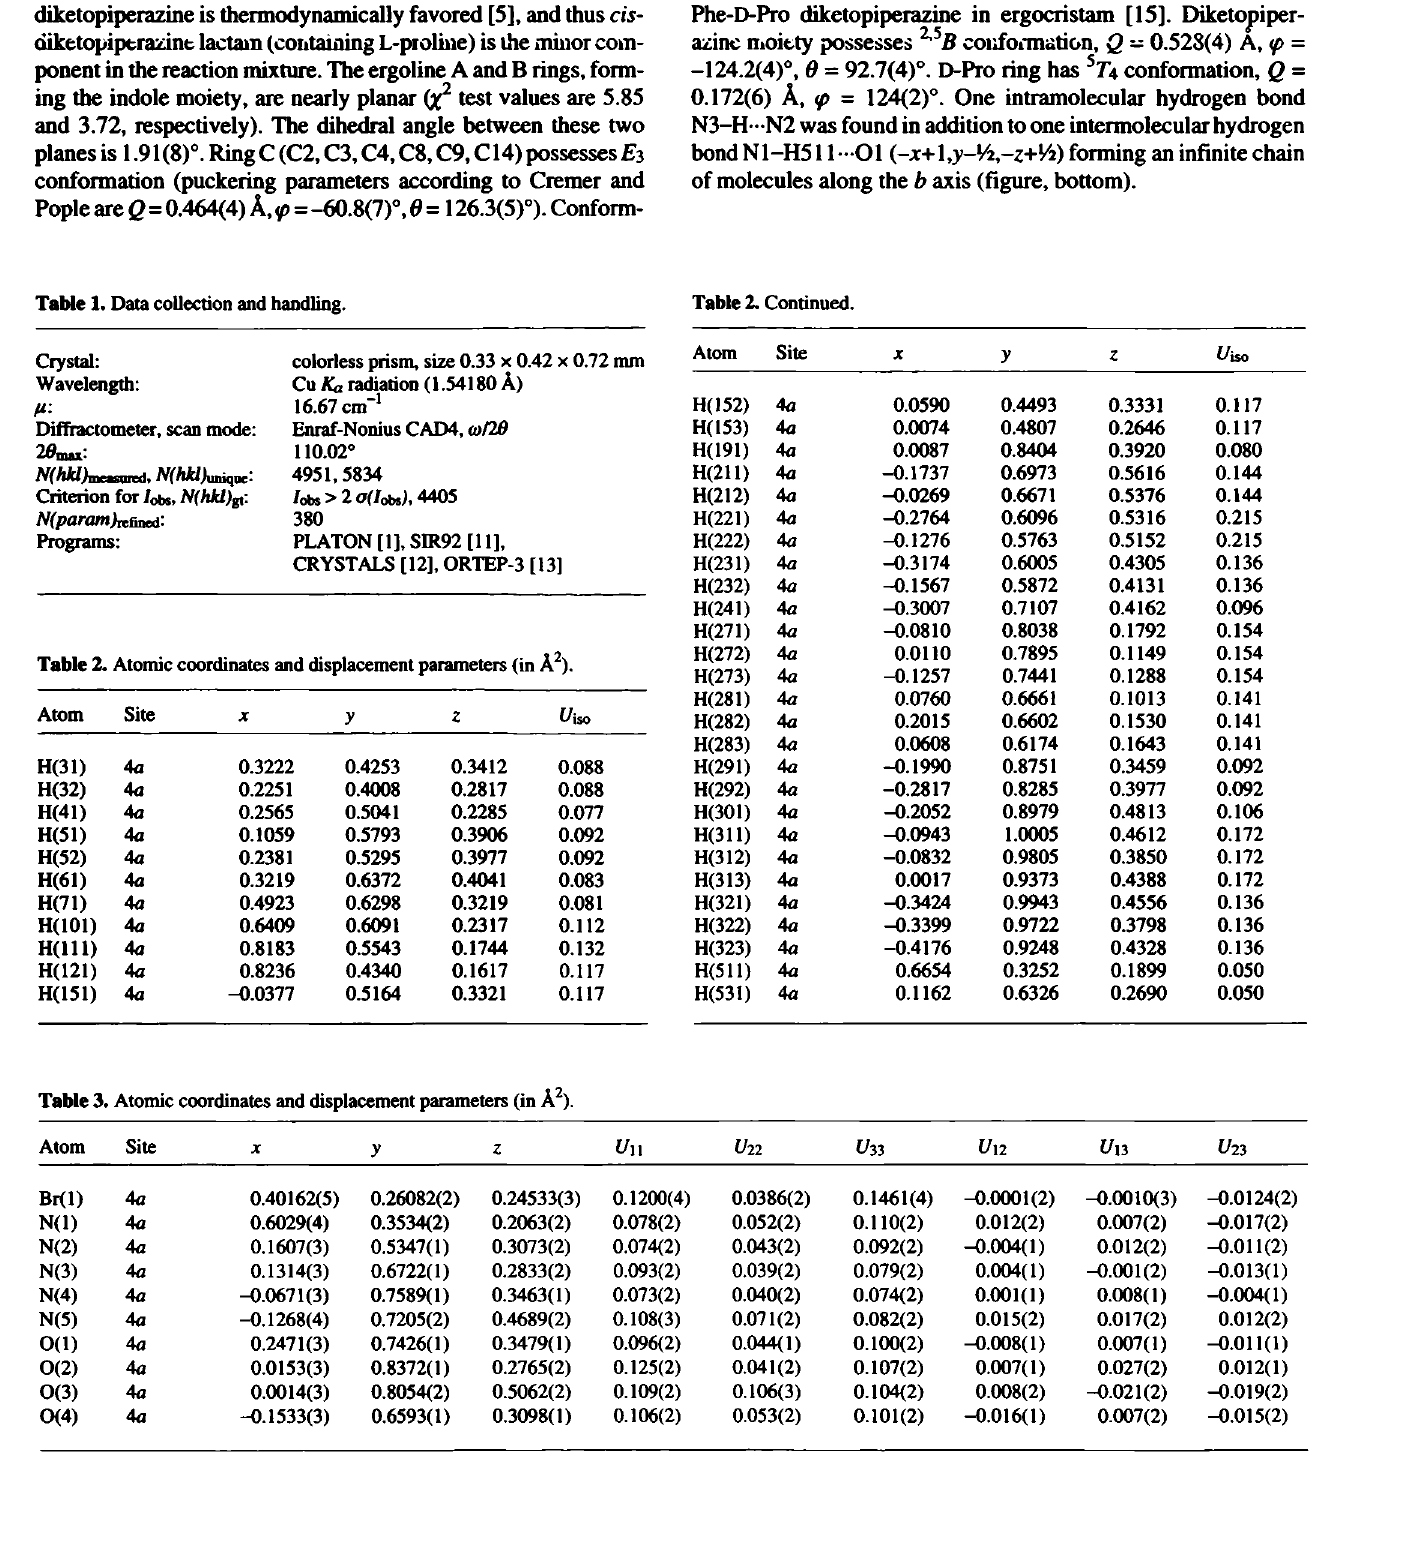
Table 1. Data collection and handling.